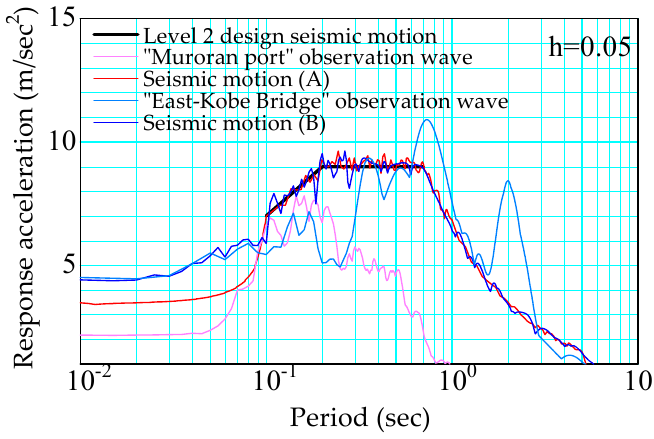
Figure 10. Acceleration response spectrum. Table 4. Duration of seismic motion (A) and (B). The upper part of each item in the table shows the value of the adjusted wave, and the lower part (in parentheses) shows the value of the original seismic wave.